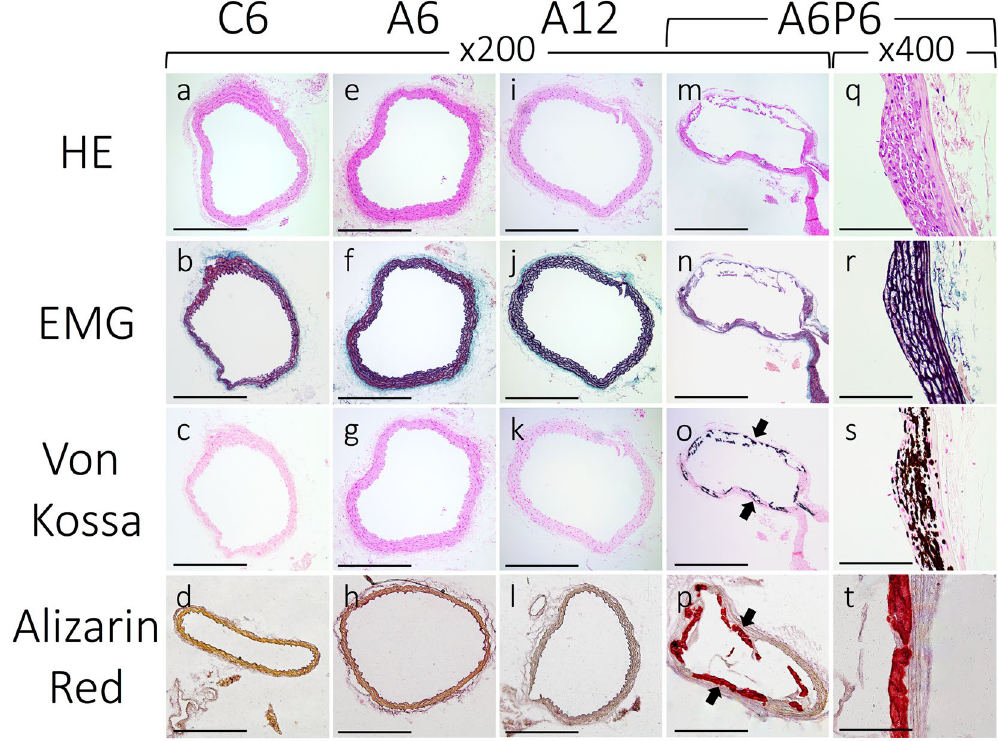
Figure 3. Representative micrographs of H&E, EMG, Von Kossa and Alizarin Red stained sections of the thoracic aorta. Sections of the thoracic aorta for the control ( a – d ), A6 ( e – h ), A12 ( i – l ), and A6P6 ( m – t ) groups are shown. Von Kossa and Alizarin Red staining positive legions were observed in CKD-HP mice ( o , p , s , t , black arrows). Images for the A6P6 mice are shown as representatives of all CKD-HP group, as calcification in A6P2 and A6P4 groups showed similar histological features (see Supplementary Fig. S1). Scale bar, 500 μ m for ( a – p )